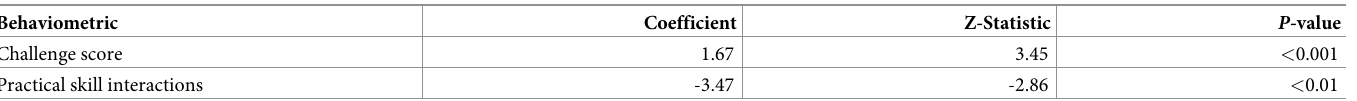
Table 2. Behaviometric predictors of expertise groups after variable reduction. Challenge score and practical skill interactions were significant predictors in the reduced logistic regression model. Behaviometric Coefficient Z-Statistic P -value Challenge score Practical skill